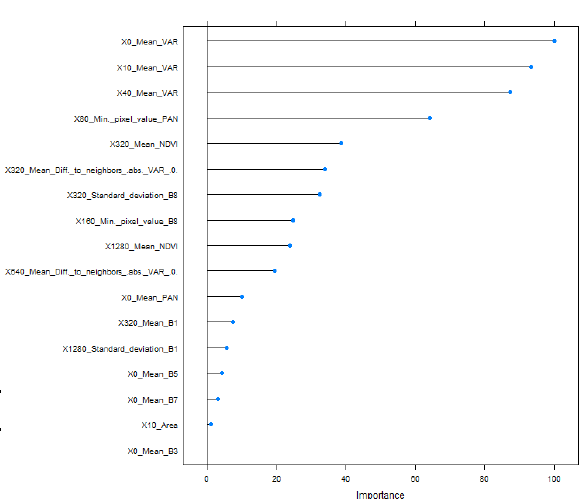
Figure 5. Permutation-based variable importance of Random Forest model (scaled to the range 0 to 100).